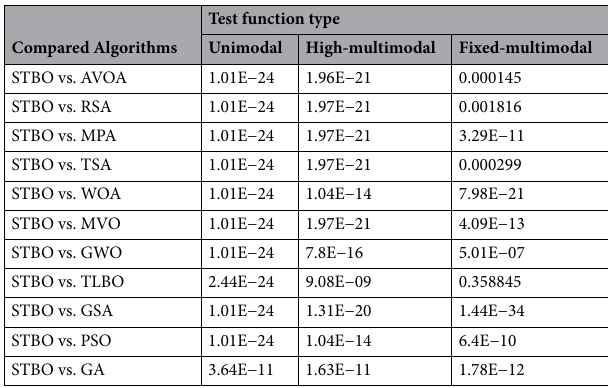
Table 6. Wilcoxon sum rank test